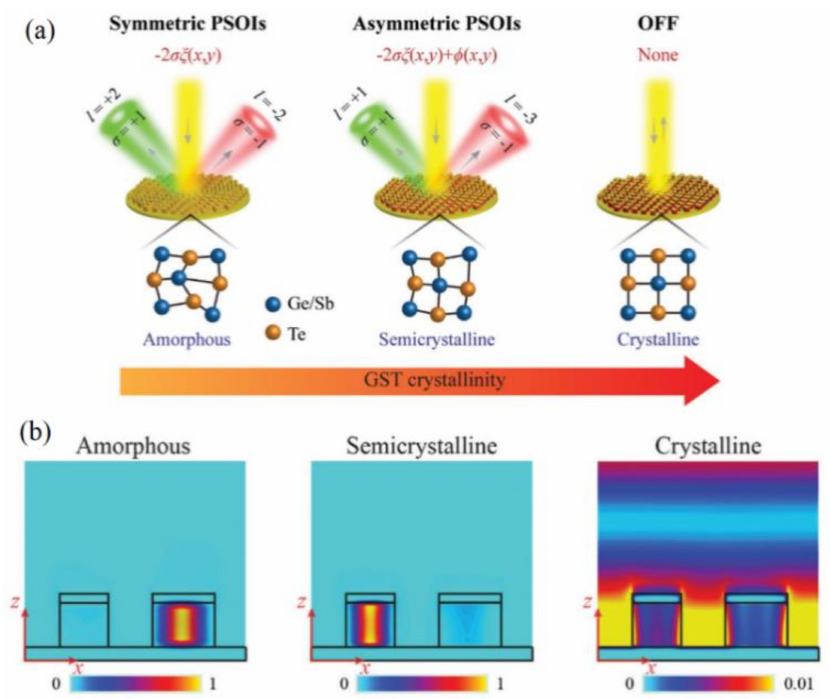
Figure 8. The multistate switching of SOIs by G 2 S 2 T 5 -hybrid metasurfaces composed of MIM nano- cavities: ( a ) three states with symmetric, asymmetric and “off” PSOIs; ( b ) the diatomic resonator used to confine the incident energy for the alternate tuning of the propagation phase—all figures in ( a , b ) are reproduced with permissions from